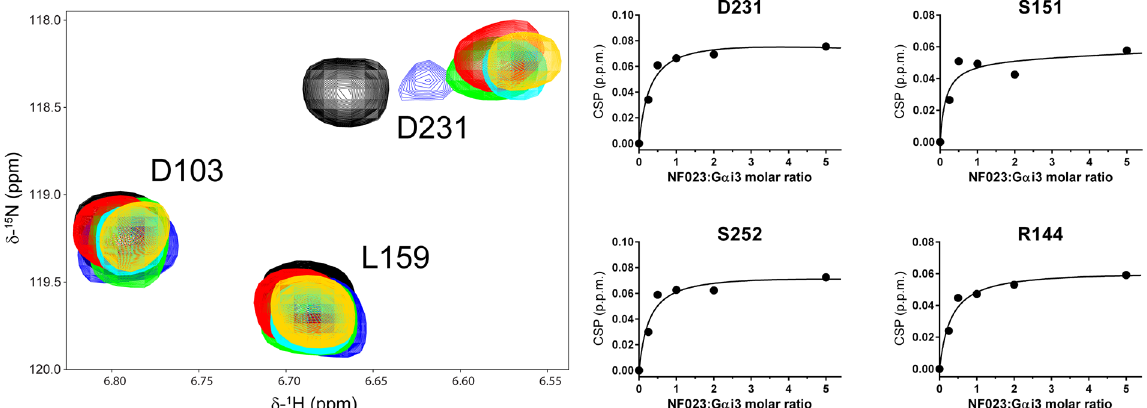
Figure 8. Overlay of 1 H- 15 N- TROSY spectra of perdeuterated G α i3 after addition of increasing amounts of NF023. Left , The selected region corresponds to one of the panels in Fig. 7B and shows the shift of the D231 signal. The contour levels are the same in all spectra. The colors correspond to the molar G α i3:NF023 ratios 1:0 (black), 1:0.25 (blue). 1:0.5 (green), 1:1 (red), 1:2 (cyan) and 1:5 (orange). Right , Plot of the measured CSP values of selected G α i3 residues (circles) and fitting to a single-site binding model (lines). The experimental error was ± 0.008 ppm.